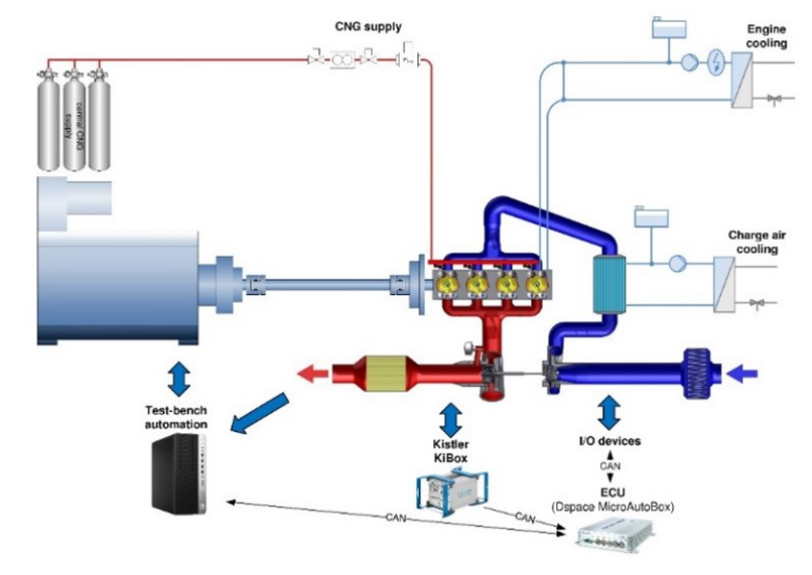
Figure 2. Test bench scheme.